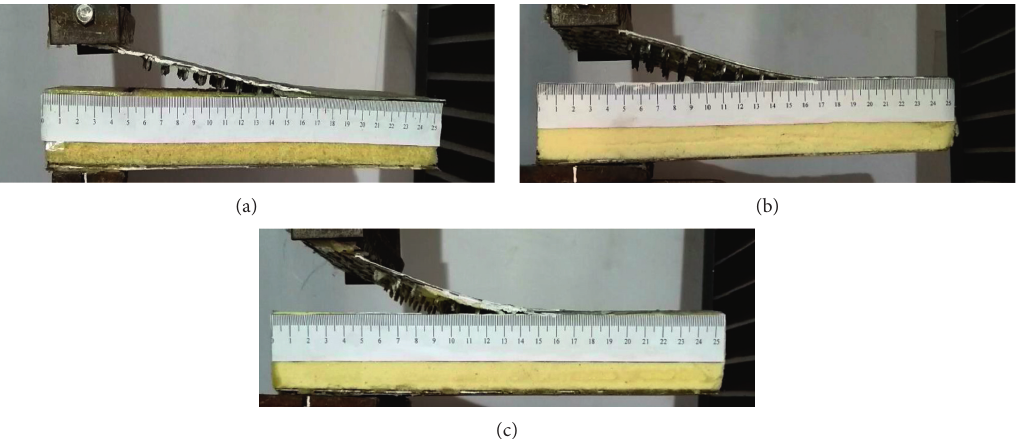
Figure 7: Failure mode of DCB specimen: (a) DCB specimen of 35 kg/m 3 foam core, (b) DCB specimen of 80kg/m 3 foam core, and (c) DCB specimen of 150 kg/m 3 foam core.